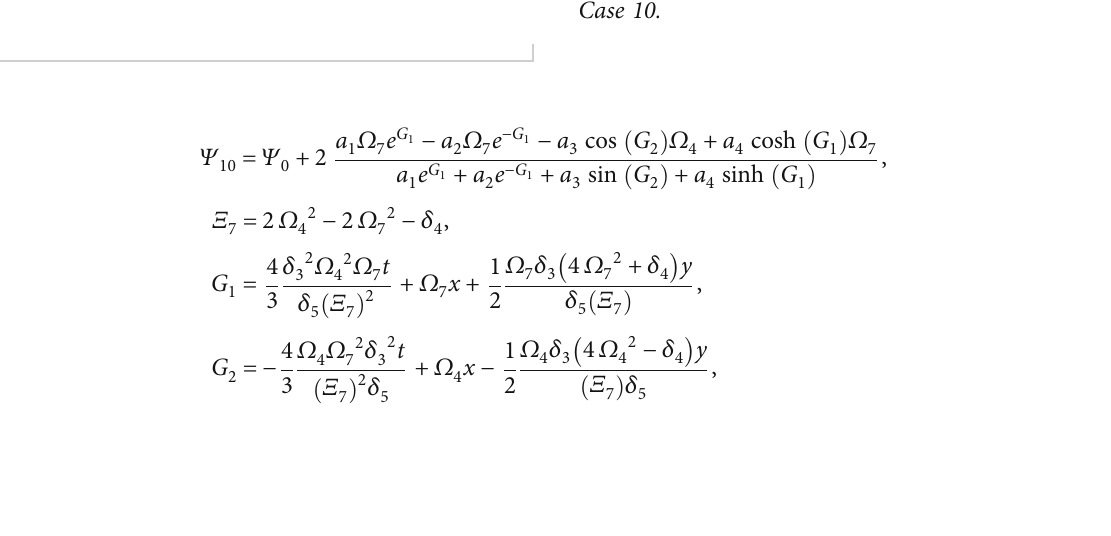
= : 5, a = 1 : 5, a = 2, a = 1, Ω = 1 : 1, Ω 1 2 3 4 1